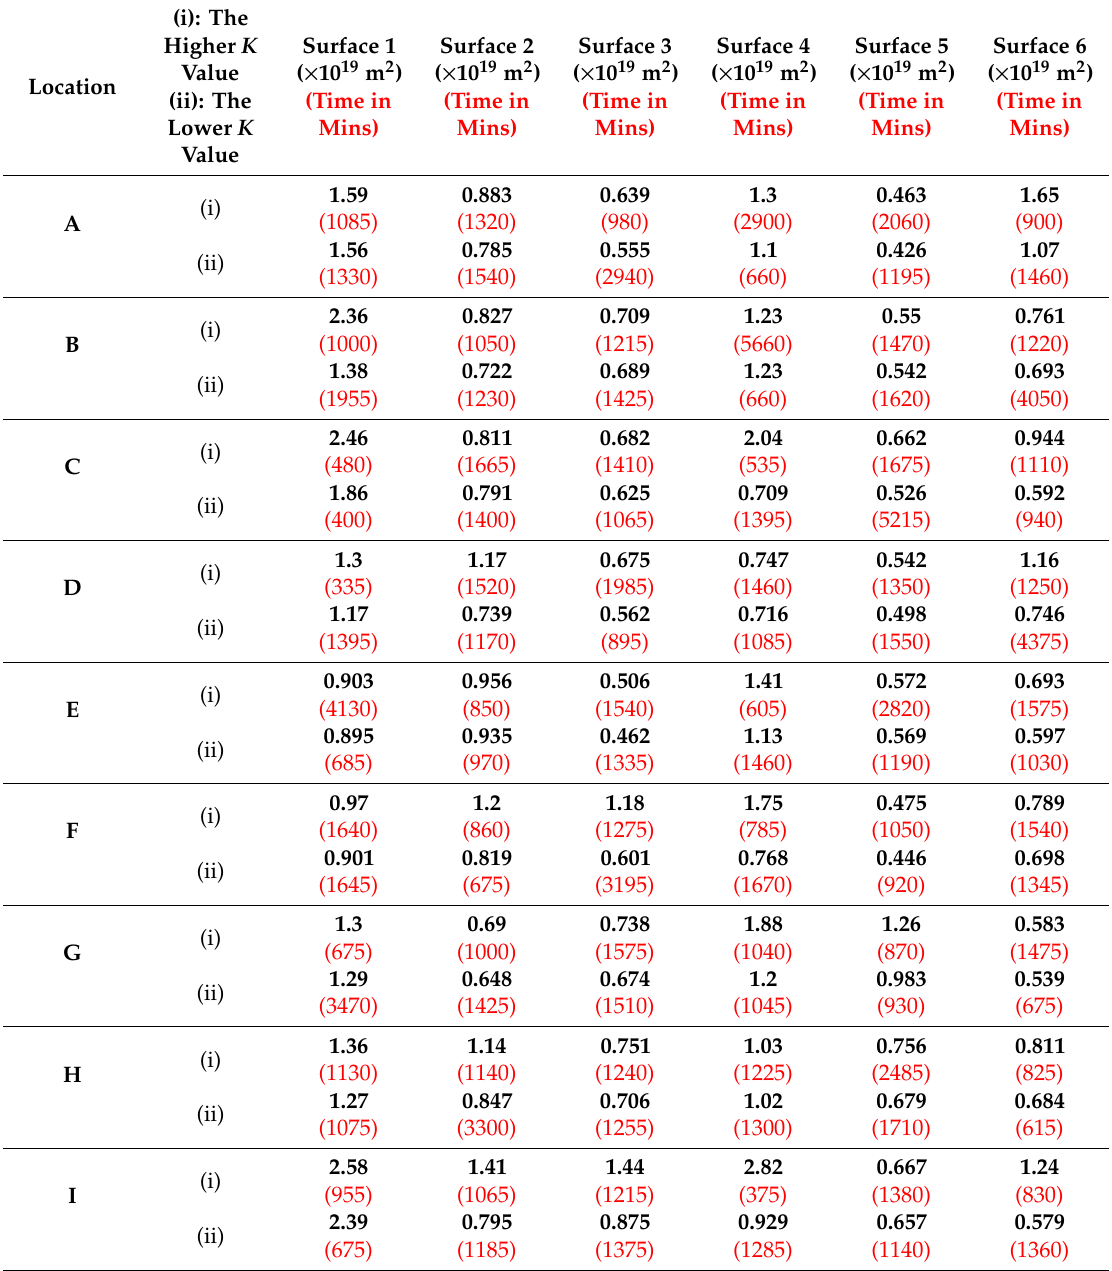
Table 4. Surface permeability data—Lac du Bonnet